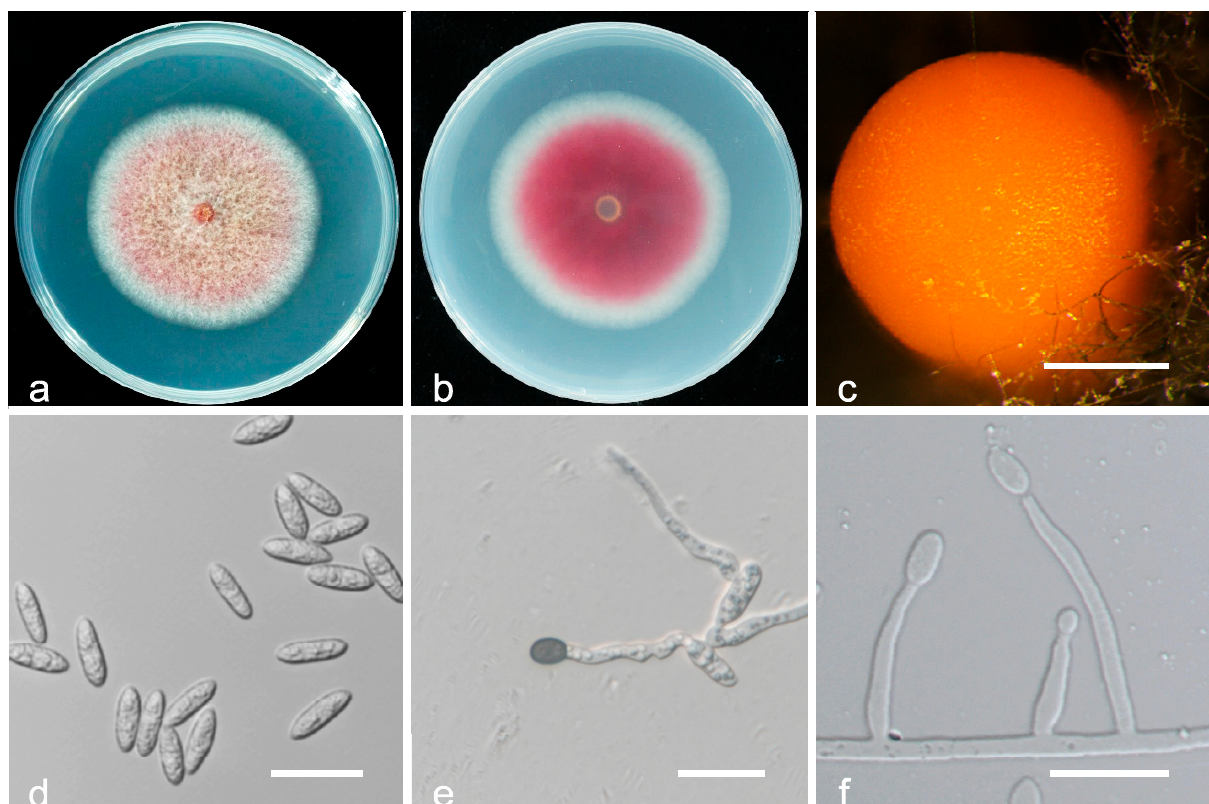
Figure 9. Biological characteristics of Colletotrichum fioriniae . ( a , b ) Front and back view of six-day-old PDA culture; ( c ) conidiomata; ( d ) conidia; ( e ) appressoria; ( f ) conidiophores (( a – e ) isolate JXJA 6; ( f ) isolate JXJA 1). Scale bars: ( c ) = 200 µ m; ( d – f ) = 20 µ m. Description and illustration—Damm et al.